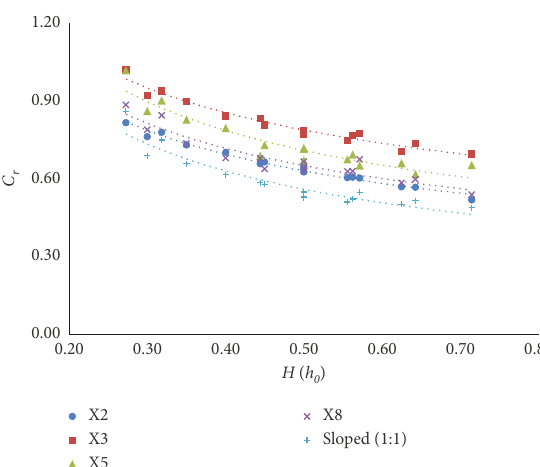
Figure 9: Comparison of numerical and theoretical results of free surface profile between 2 and 3 seconds of wave generation with H 0.25m and h 0 0.35 m. (cid:30) (cid:30)